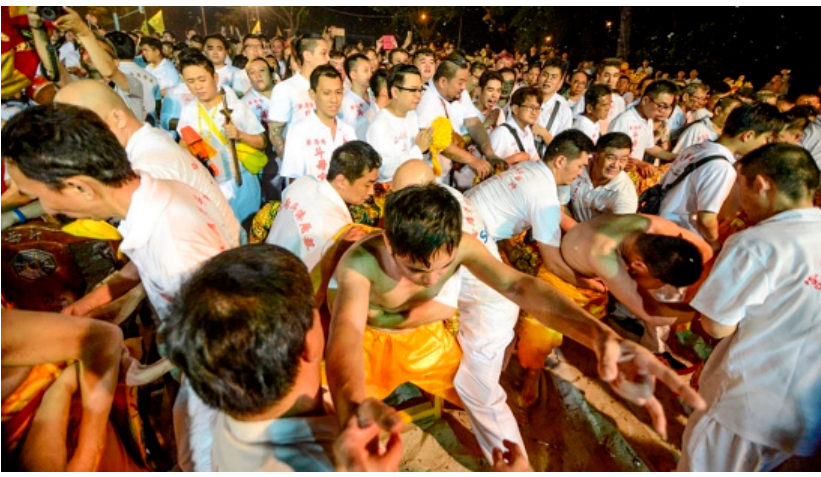
Figure 6. The spirit mediums are tranced into the Nine Emperor Gods 10 .